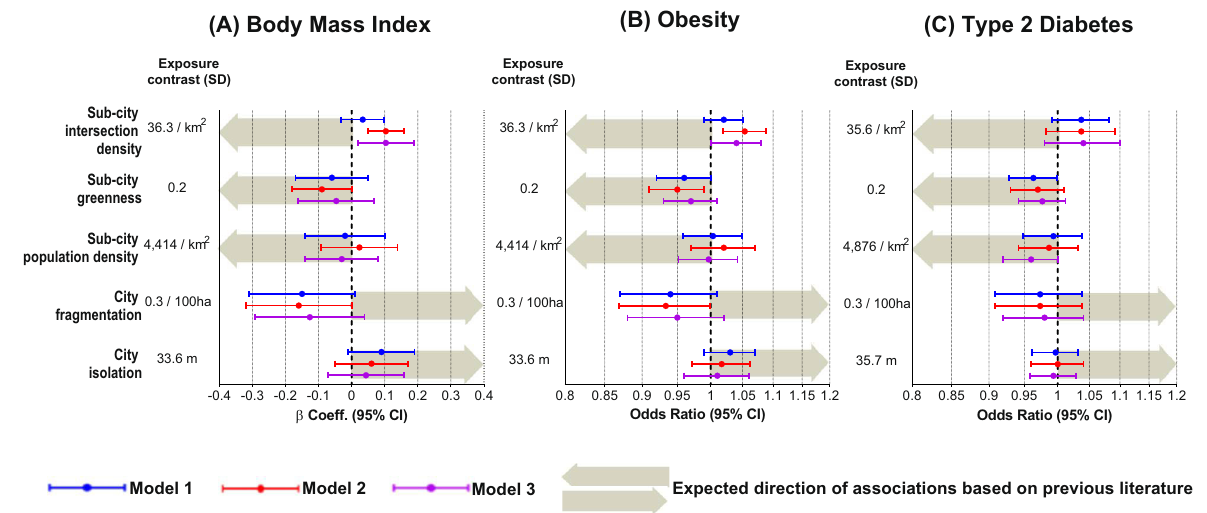
Fig.2|Associationsbetweenbuiltenvironmentcharacteristics,assingle(each built environment exposure ata time) or multiple exposure models (multiple builtenvironmentexposurestogether),andBMI,obesity,andtype2diabetes, adjusted for covariates. Allexposures werestandardized to a meanof zeroand a standard deviation (SD) of 1, therefore the exposure contrast used is1SD for each variable. For body mass index (BMI, n =93,280), the β coef fi cient represents the mean change in BMI per one SD increase in the exposure, adjusted for covariates. Forobesity( n =93,280)andtype2diabetes(T2D, n =122,211),eachoddsratio(OR) representstherelativechangeintheoddsofhavingobesityorhavingT2Dperone SD increase in the exposure, adjusted for covariates. Error bars show 95% con- fi dence intervals (95% CI). Arrows indicate the expected direction of the associa- tions based on previous literature (further information about these previously reported associations is provided in the Results, Discussion, and Methods sections of the manuscript). Arrows pointing to the left indicate a